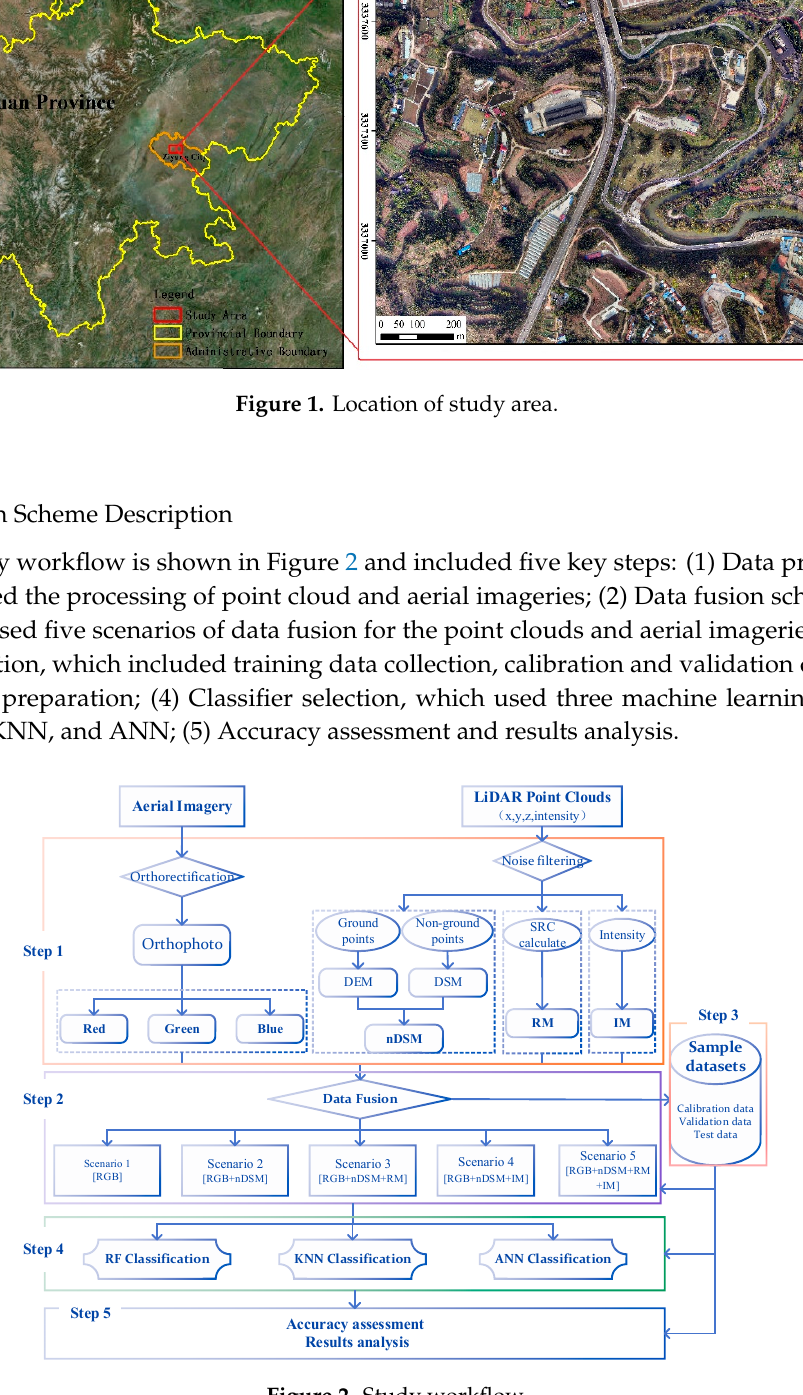
Figure 2. Study workflow.